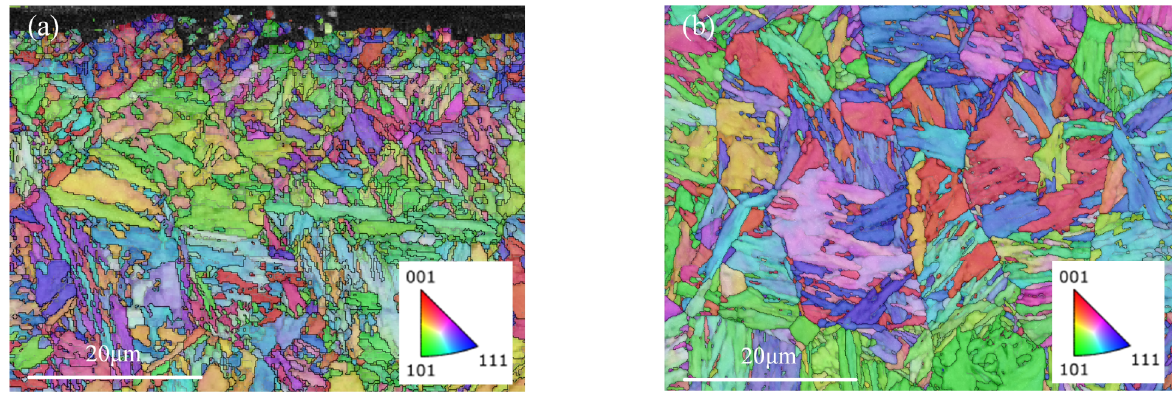
Figure 5. EBSD results of the microstructure of gears before grinding: ( a ) Surface of the gear; ( b ) core of the gear.